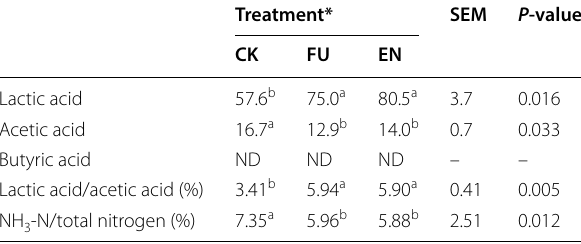
Table 3 Effects of different additive treatments on the fermentation quality (g kg − 1 DM, unless stated otherwise) of whole crop maize silage after 30